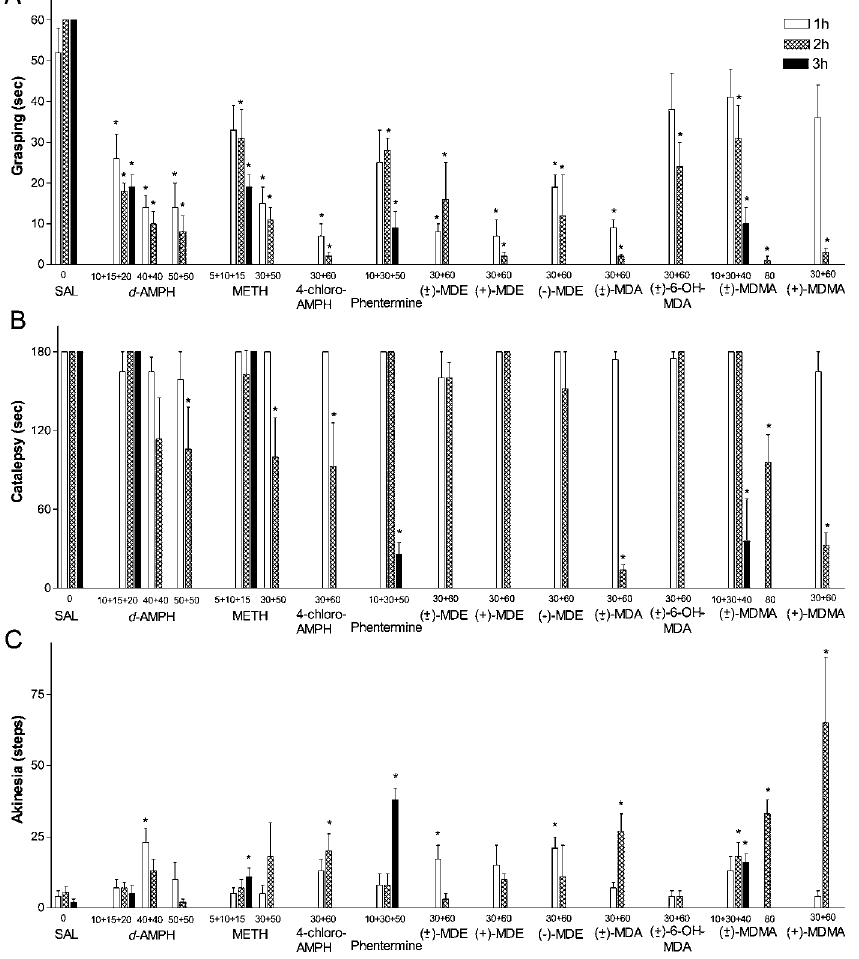
Figure 5. Amphetamine Derivatives at High Doses Are Effective in Reversing Abnormal Motor Behaviors of DDD Mice DAT-KO mice were placed in the locomotor activity chamber and 30 min later were treated with a MT (250 mg/kg IP), and 1 h after a MT were challenged with single or multiple doses of drugs (in cumulative dosing experiments, the interval between treatments was 1 h). Grasping (A), catalepsy (B), and akinesia (C) tests were performed as described in Materials and Methods 1 h after each dose (the only exception is ( 6 )-MDMA at 80 mg/kg IP where measurements were performed 2 h after the drug administration). An asterisk indicates p , 0.05 versus respective values of saline-treated DDD mice (one-way ANOVA followed by Dunnet’s multiple comparison test). Experiments were performed in 6–16 mice per group. d -AMPH indicates d - amphetamine; METH, d -methamphetamine; and 4-chloro-AMPH,